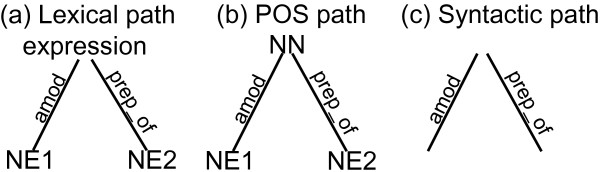
Shortest path dependency trees for one of the protein pairs in the sentence from Example 1. Figure 3 depicts the shortest path dependency trees for the protein pair sigma(H)-spo0A built from the dependency tree of the sentence: "In the shaA1 mutant, sigma(H)2-dependent expression of spo0A3 and spoVG4 at an early stage of sporulation was sensitive to external NaCl."